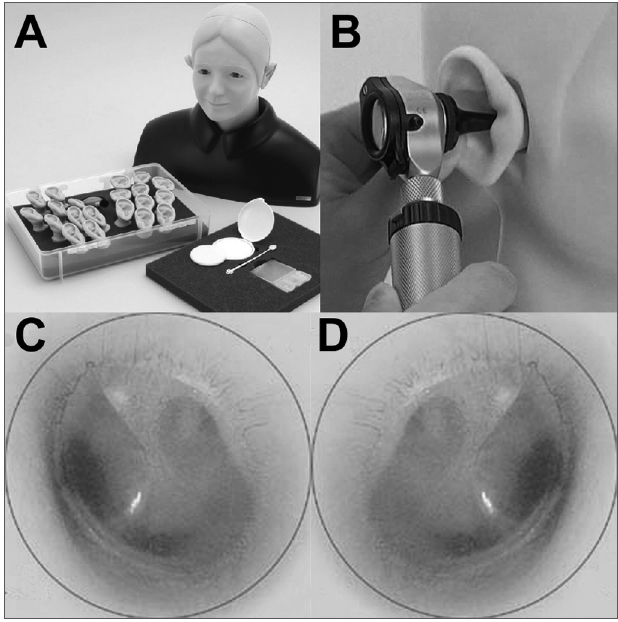
Figura 1. Modelo para ensino e treinamento de otoscopia. A: modelo com cabeça e diferentes partes móveis com vários tipos de doenças e otoscopias. B: prática de otoscopia em modelo. C: exemplo de otosco- pia normal de membrana timpânica esquerda em modelo. D: exemplo de otoscopia normal de membrana timpânica direita em modelo. Note triângulo luminoso, membrana com coloração discretamente perolácea e visão de parte da cadeia ossicular e tuba auditiva por transparência.